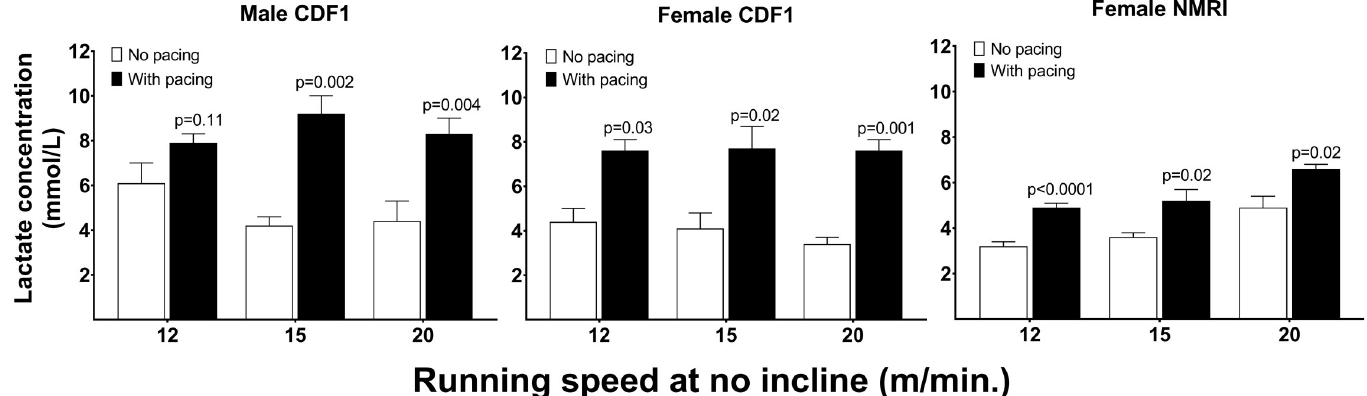
Fig 4. Mean ( ± SEM) blood lactate concentration (mmol/L) immediately post-exercise at different running speeds (m/min) in 6 male and 6 female CDF1 and 5 female nude NMRI mice for 20 minutes either without (designated with a white square) or with (designated with a black square) a standardized pacing regime. The specific p-values (Students paired t-test) report the statistical difference between blood lactate concentrations at the same running speed with and without pacing.